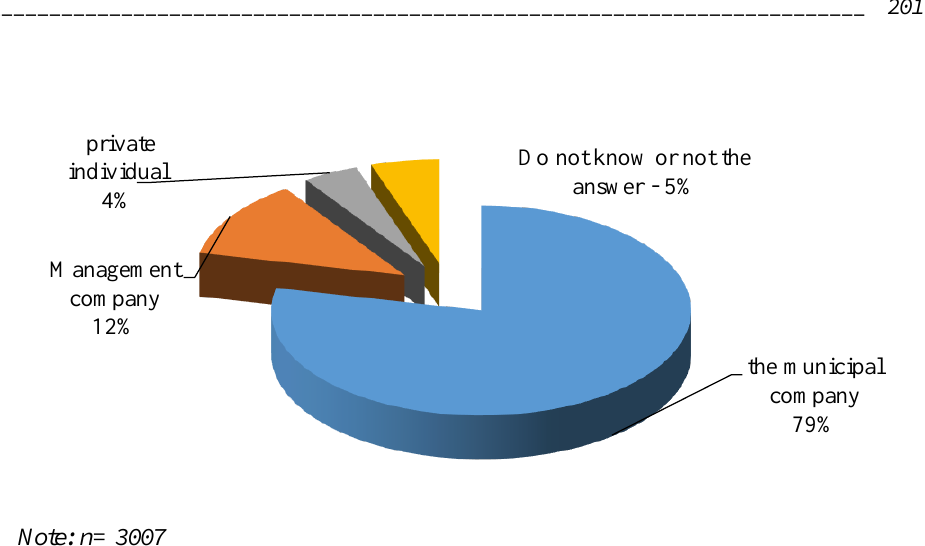
Fig. 5. The manager of respondents’